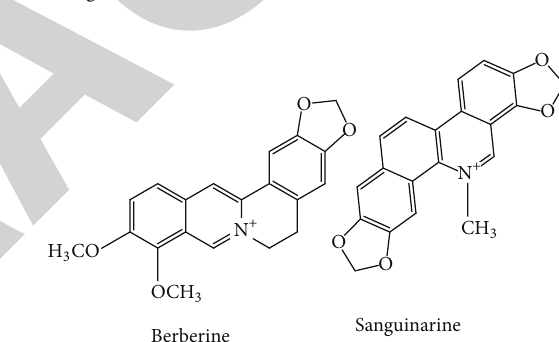
Figure 1: Effect of gamma irradiation on flavonoid and phenol compounds of in vitro leaves. The means of the samples with the same small letters were not significantly different as per Duncan’s multirange test at 𝑃 < 0.05 .